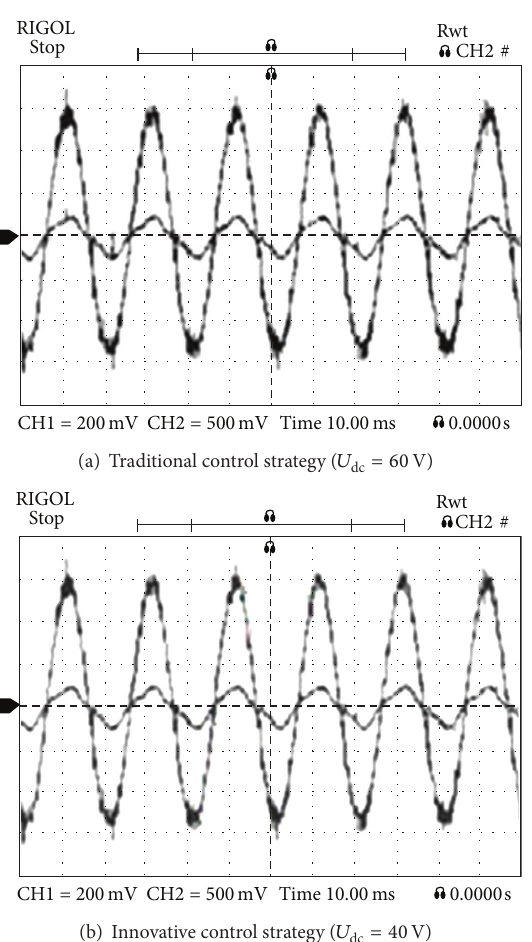
Figure 5: Output results under different control